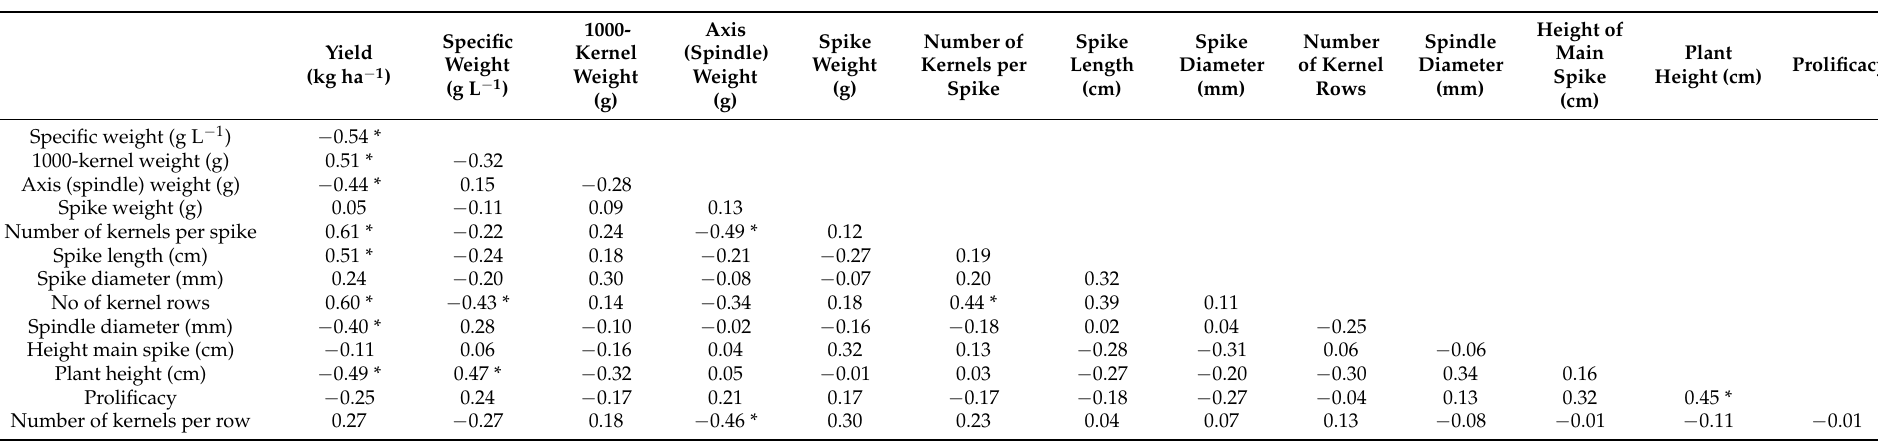
Table 8. Correlations between all traits measured: yield (kg ha − 1 ), specific weight (g L − 1 ), 1000-kernel weight (g), axis (spindle) weight (g), spike weight (g), number of kernels per spike, spike length (cm) and diameter (mm), number of kernel rows, spindle diameter (mm), main spike and plant height (cm), prolificacy, and number of kernels per row.